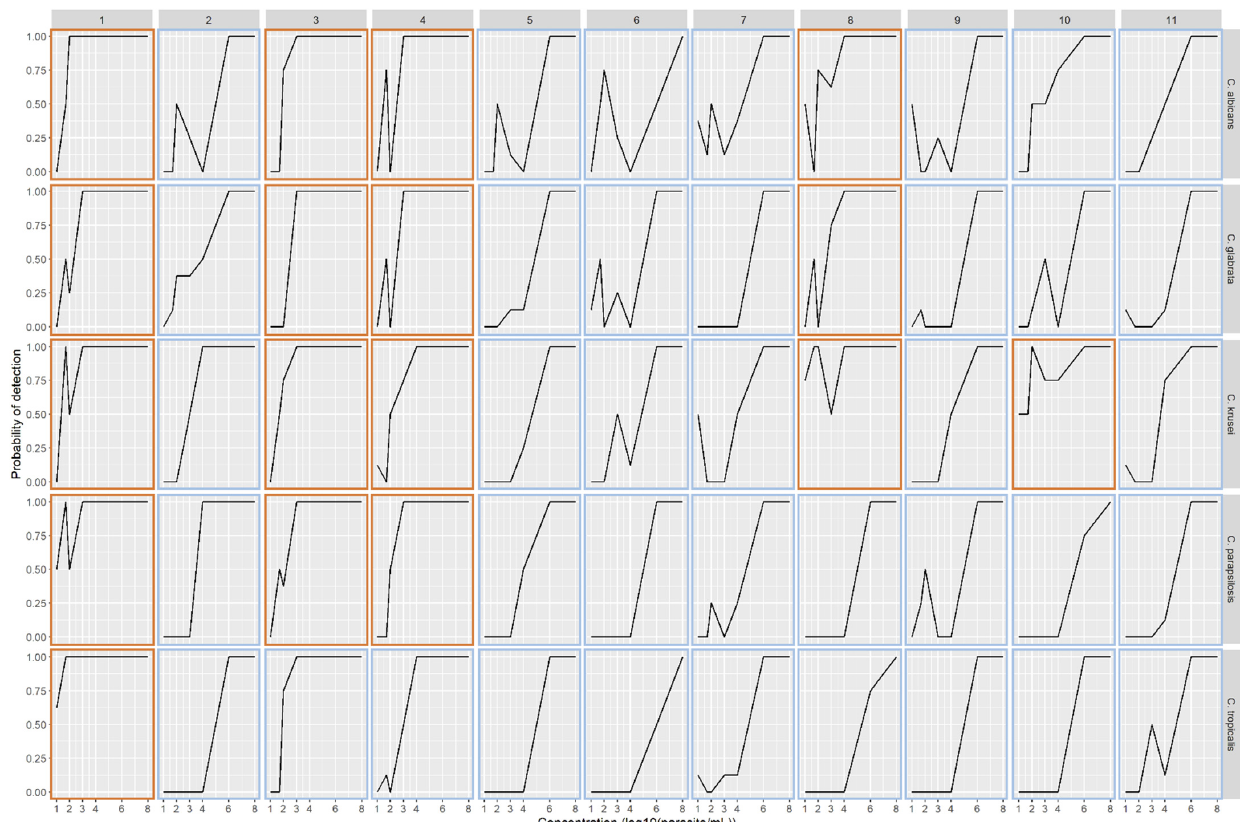
Figure 3. The probability of obtaining at least one PCR positive result (Ct < 45) on the duplicate from the two extractions for each inoculum concentration according to the Candida species and the automated method used.